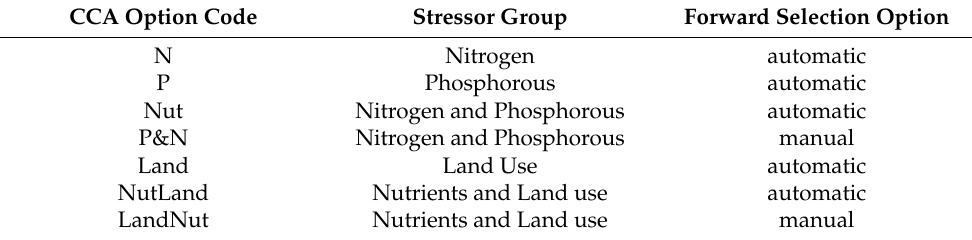
Table 3. Canonical Correspondence Analyses (CCA) option codes performed with macrophytes and phytobenthic diatoms assemblages and used with the environmental variable stressor groups and forward selection